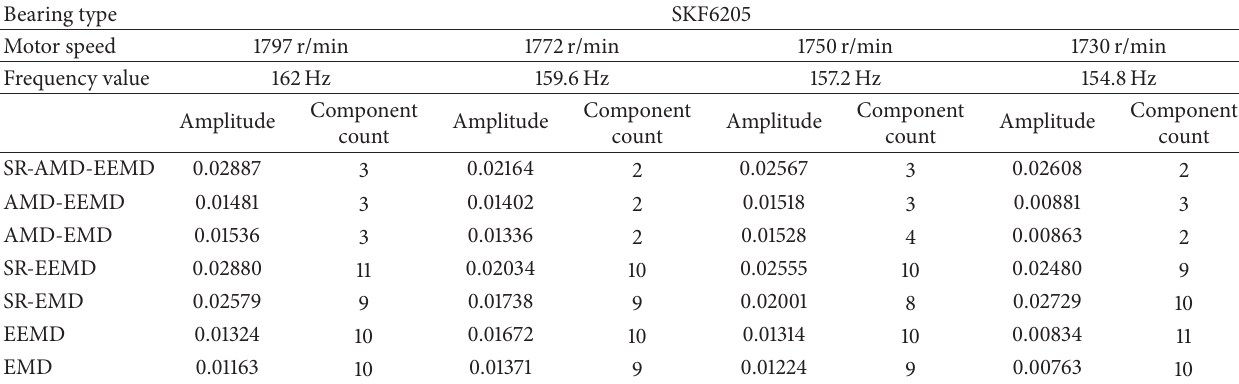
Table 5: The amplitude and component count of fault feature frequency of SKF6205 under different rotational speed.